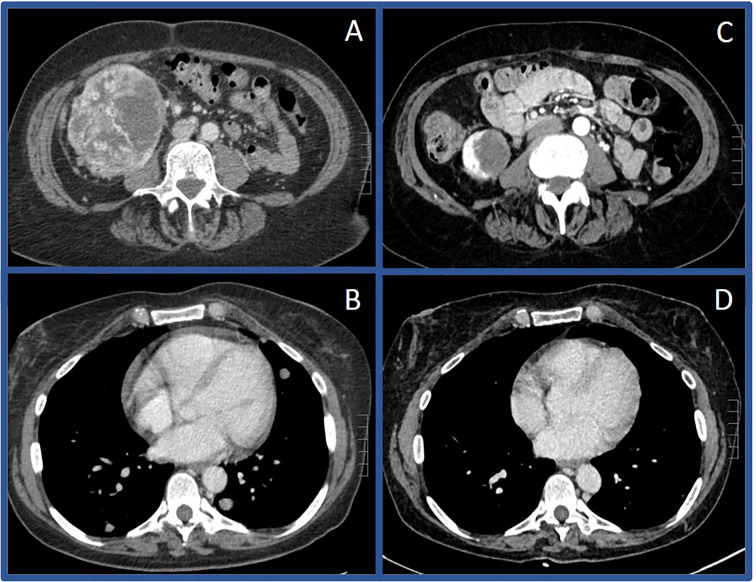
Computerized tomography scans before and after immunotherapy in Case #2 Initial CT scan in July of 2018 showing large right renal mass (A) and pulmonary metastases (B) compared to CT scan in December of 2019 showing substantially decreased mass (C) and resolution of pulmonary metastases (D).